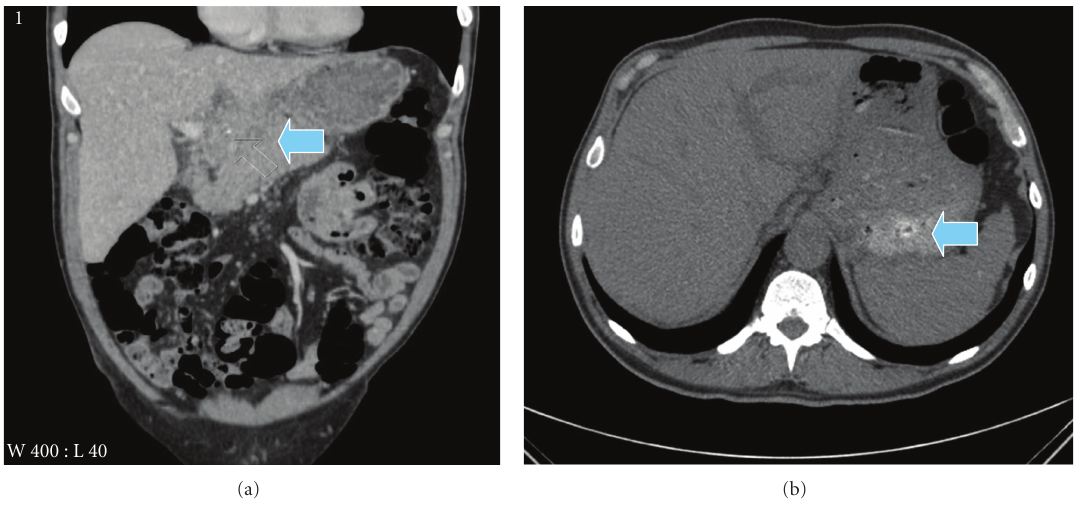
Figure 1: CT scan revealing a complex soft tissue mass in relation to the pancreas with a calcified